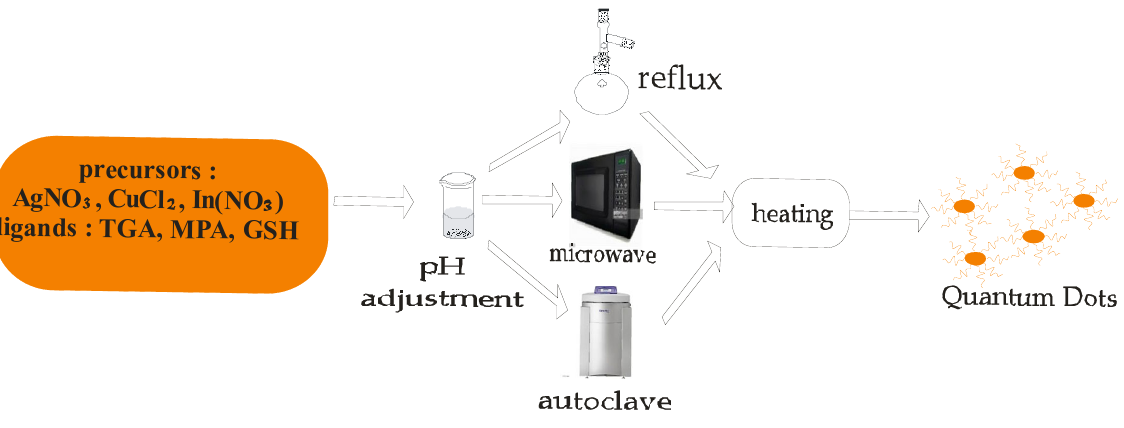
Figure 8. Synthetic scheme for quantum dots in aqueous medium.